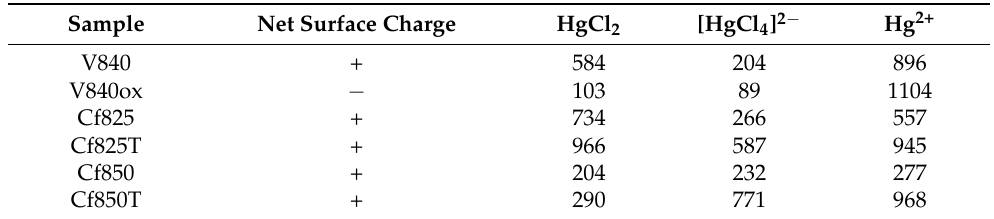
Table 2. Maximum adsorption capacity of mercury species in mg/g and net surface charge of the activated carbons.